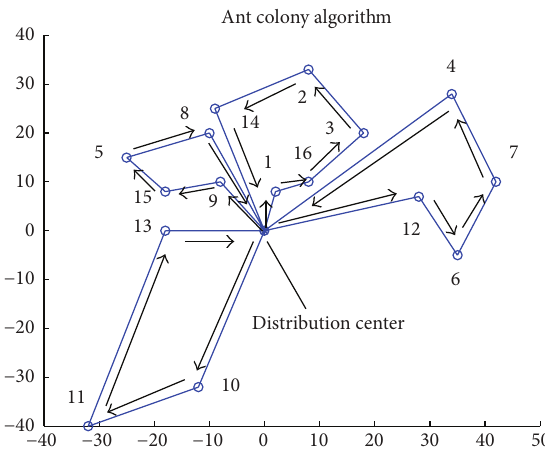
Figure 5: Distribution path basic ant colony algorithm (top or good air pollution level).